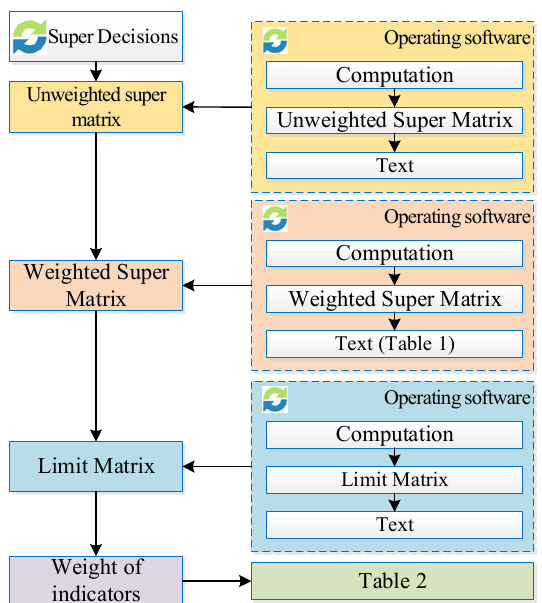
Figure 4. Calculation process of index weight.